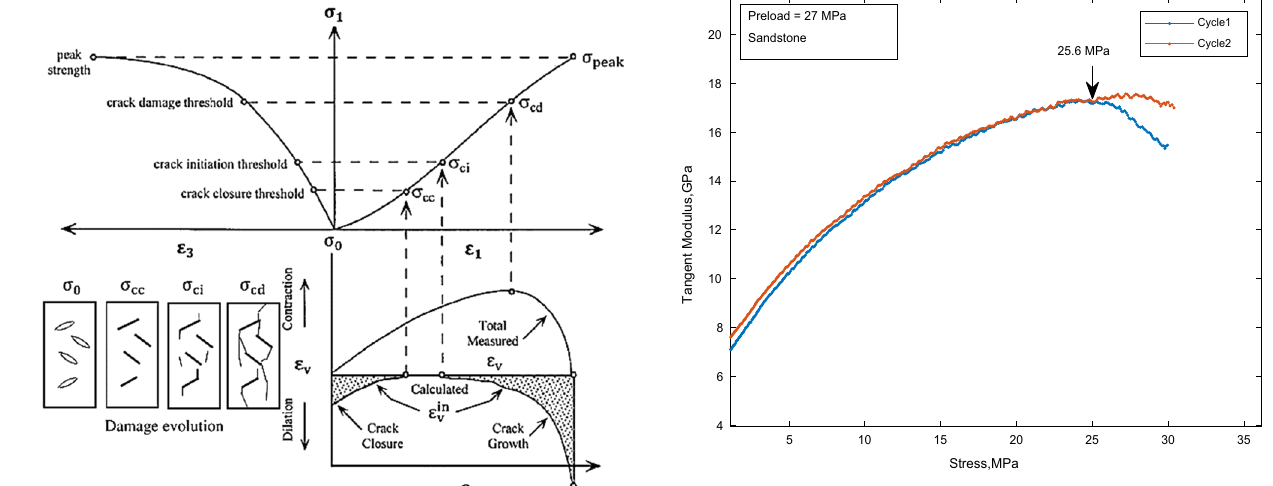
Fig. 1 Damage Mechanism in rocks (Bruning et al. 2018)